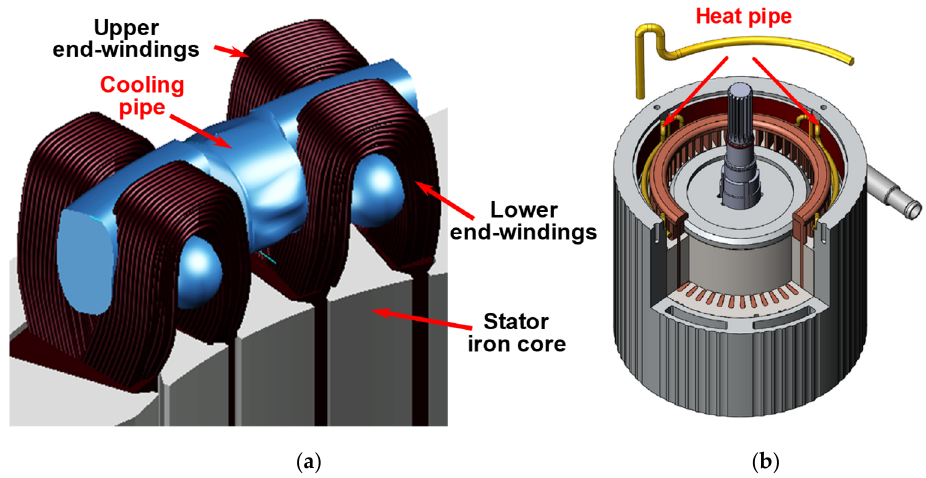
Figure 6. Direct cooling of the end ‐ windings. ( a ) Cooling duct inserted in the middle of the end ‐ windings, reproduced with permission from the owner, Madonna, V. [126]; ( b ) heat pipe placed near the end ‐ windings, reproduced with permission from [127]. Copyright Elsevier 2019.